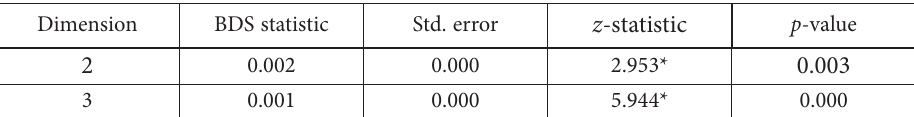
Table 11. BDS test results for Tax = f ( GDP, GDP 2 , FD )